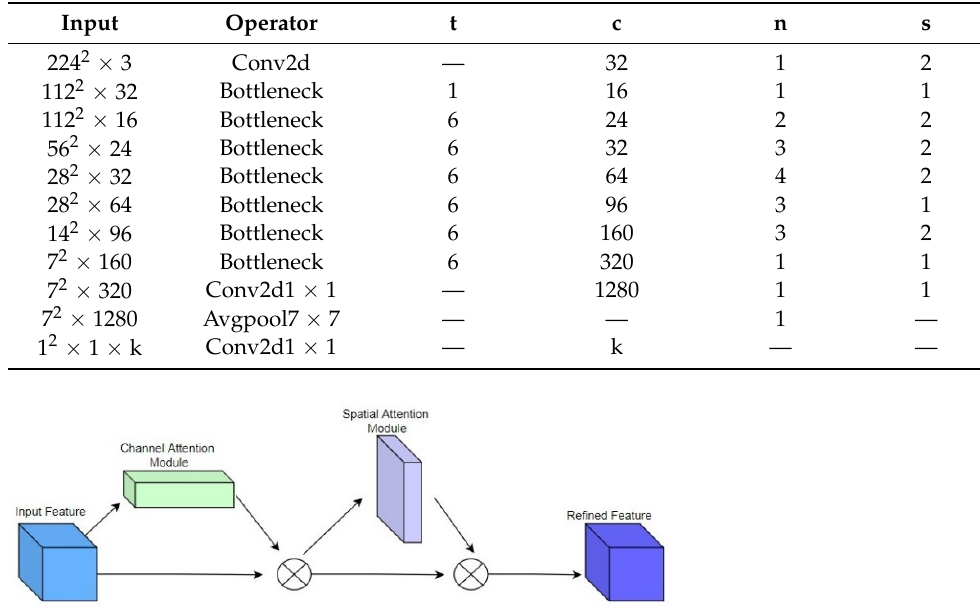
Figure 3. CBAM Structure Diagram.